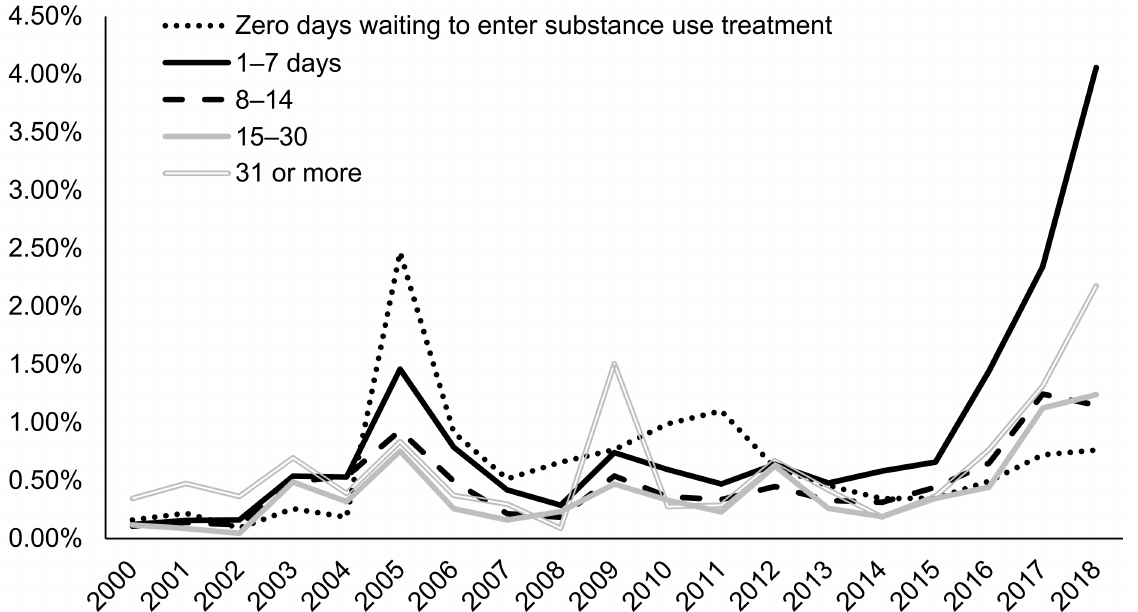
Figure 8. Prevalence of naltrexone treatment prescribed in alcohol use disorder (AUD) admissions from 2000–2018 by days waiting to enter treatment using TEDS-A data. Temporal trends were significant by the Cochran–Armitage trend test ( p <